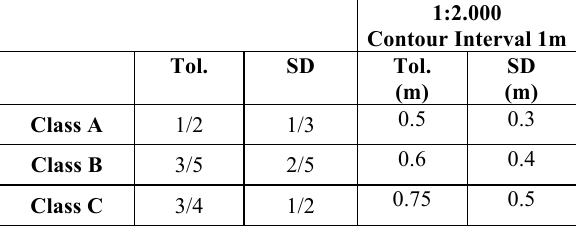
Table 2: PEC altimetric thresholds for 1:2,000 scale.